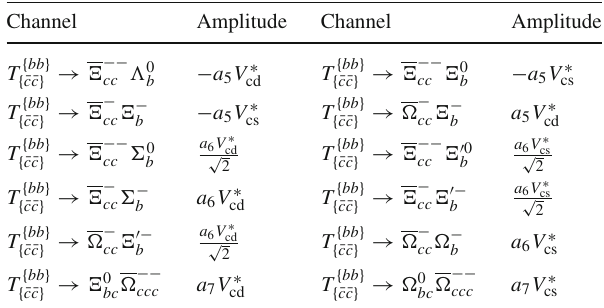
{ bb } Table 3 Tetraquark T {¯ c ¯ c } decays into doubly charmed baryon plus singly bottom baryon for the transition of b → c ¯ cd / s Channel Amplitude